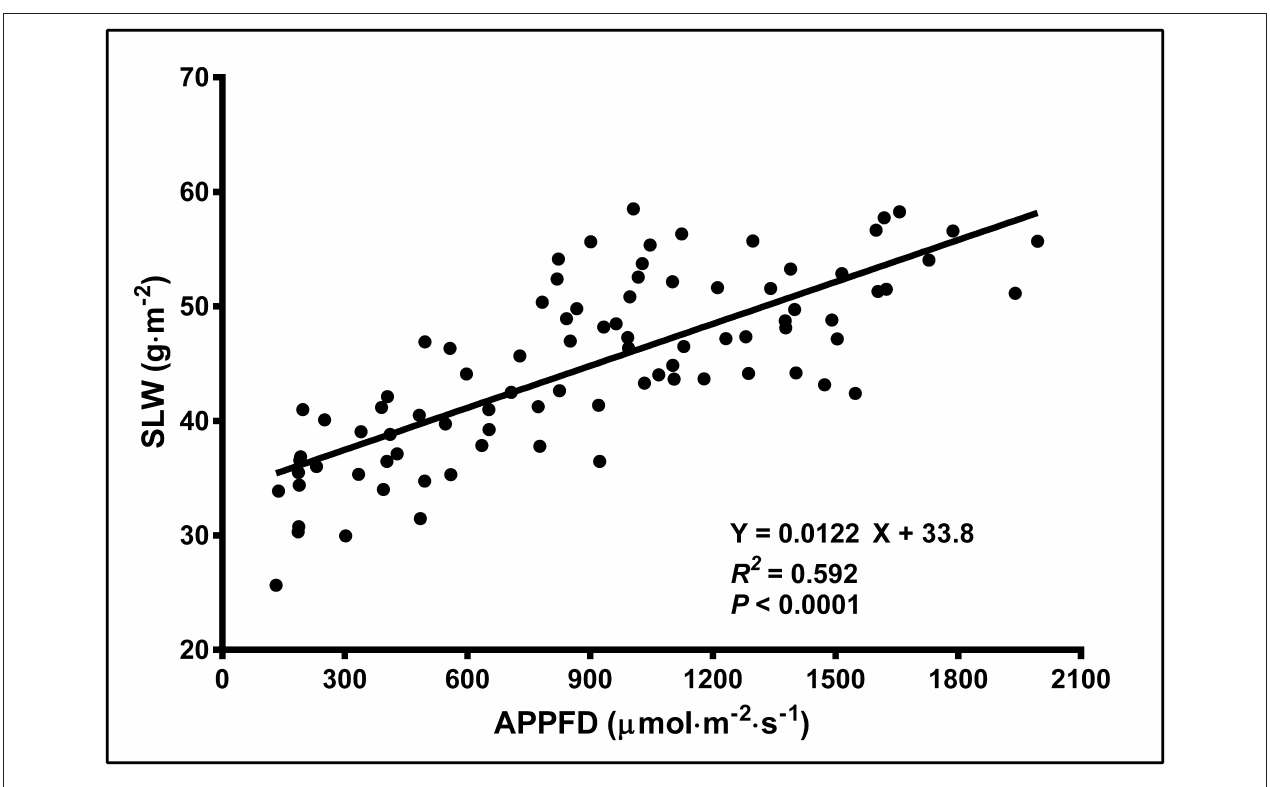
FIGURE 5 | The specific leaf weight (SLW; on a dry weight basis) of young, fully-expanded Cannabis sativa ‘Stillwater’ leaves in response to the average photosynthetic photon flux density (APPFD), measured on day 35 after initiation of the 12-h photoperiod. Each datum represents one fan leaf from a single plant.